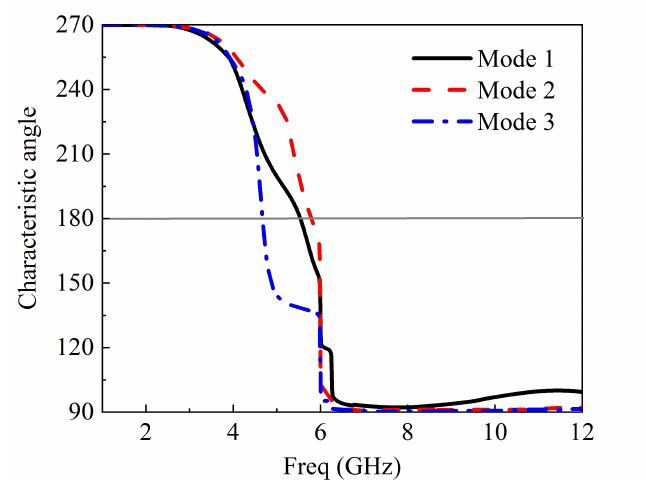
Figure 13. The characteristic angle of three modes at 5.5